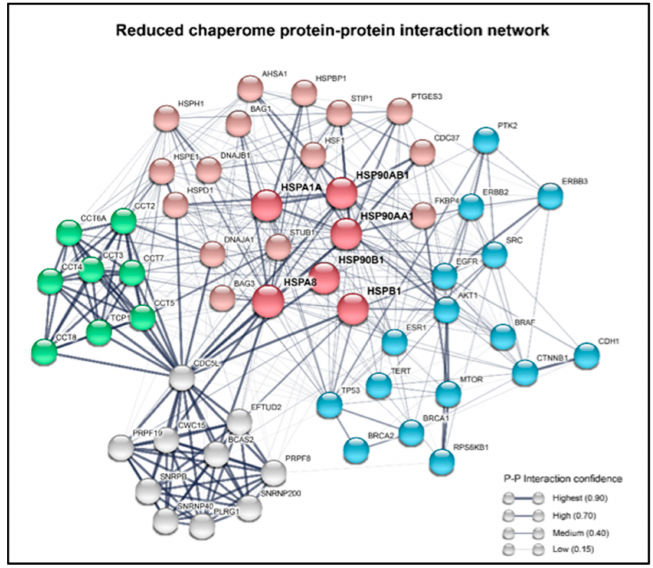
Figure 3. A reduced chaperome network is shown with the representation of the physical connections between the chaperome and the various proteins that can powerfully influence tumorigenesis. A summary of the protein–protein interaction network of the major HSPs. In the network, the nodes represent the most important constituents of the chaperome, which are connected with other proteins by edges of varying width. Red nodes are code for the main HSPs and co-chaperones, blue are well known cancer-related genes, the TRiC complex genes are shown in green, and the Prp19 / CDC5L complex genes are in grey. The line thickness of the edges indicates the strength of the experimental data supporting a protein–protein interaction. The network was built using the STRING database (https: // string-db.org) from the Swiss Institute of Bioinformatics and the European Molecular Biology Laboratory